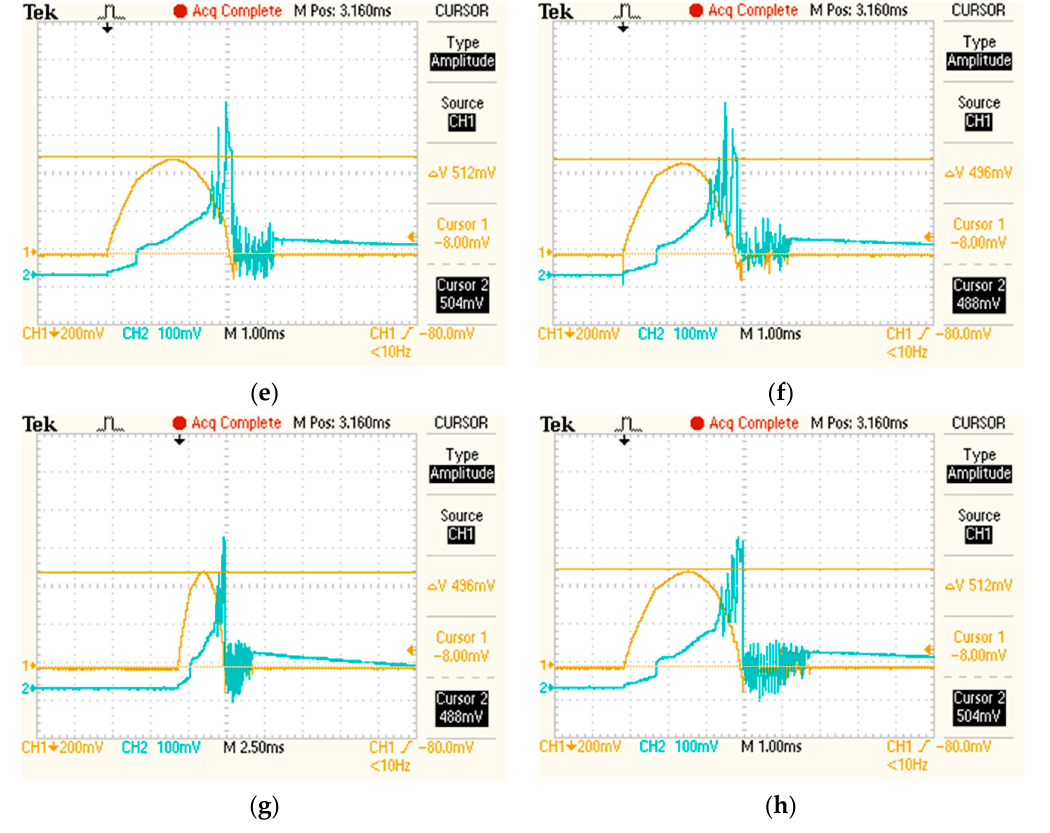
Figure 15. A recorded sample of short-circuit current and recovery voltage waveforms during short- circuit tests performed in the High-Current Laboratory at the Warsaw University of Technology. Different cases from ( a – h ).